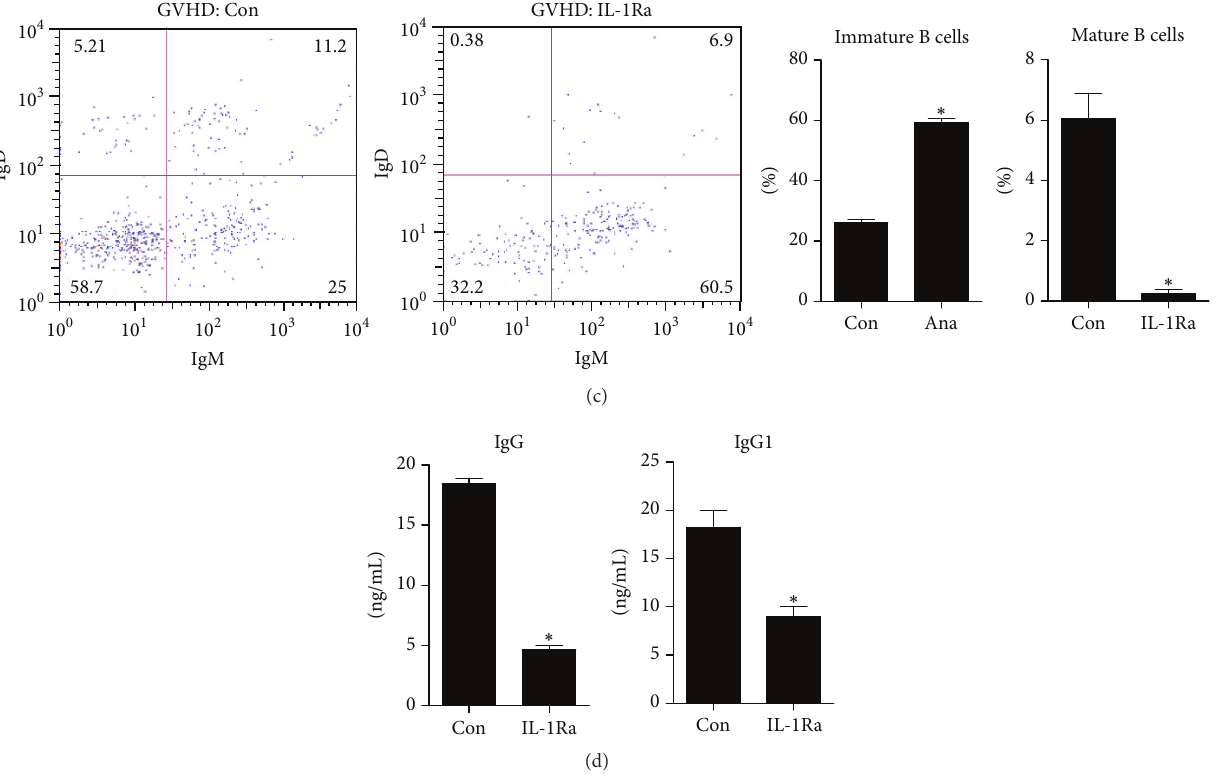
Figure 5: Analysis of B cells and CD4 + T cells in mice with acute graft-versus-host disease (GVHD), in whom splenocytes were treated with IL-1 receptor antagonist (IL-1Ra): (a) to elucidate the in vivo mechanism of action of the blockade of IL-1 signaling in amurine model of acute cells among ex vivo splenocytes from each group by means of GVHD, we analyzed the proportion of Th1, Th2, and Th17 and (b) shows T reg flow cytometry. (c) The share of the B-cell subset was analyzed using flow cytometry. B220 + B cells included IgM high IgD low (immature B cells) and IgM low IgD low (mature B cells). (d) shows The level of IgG in serum. ∗ 𝑃 < 0.05 , ∗∗ 𝑃 < 0.01 . Data are representative of 2 independent